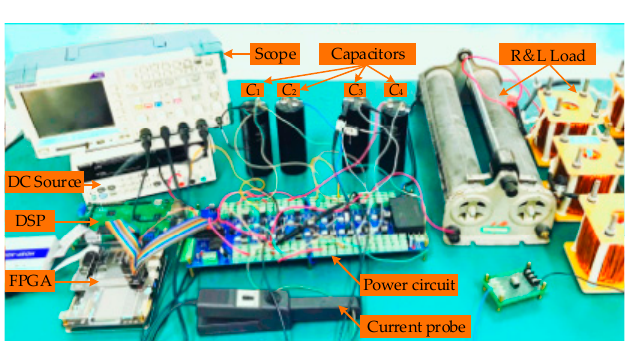
Figure 16. The experimental platform.